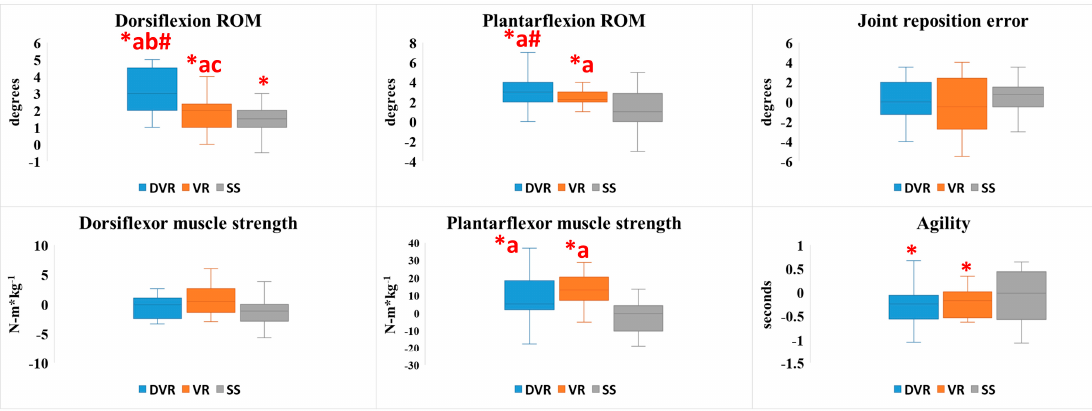
Figure 4. Changes from pretest to postintervention in ankle range of motion (ROM), proprioception, muscle strength, agility after the dynamic contraction with vibration rolling (DVR), vibration rolling (VR), and static stretching (SS) conditions. * Change was statistically significant at p < 0.05. a Significant di ff erence ( p < 0.05) compared with SS. b Significant di ff erence ( p < 0.05) compared with VR. c Significant di ff erence ( p < 0.05) compared with DVR. # change values reached moderate e ff ect